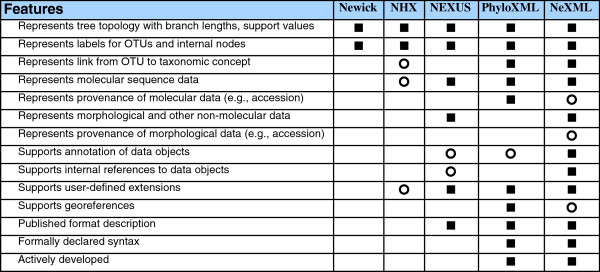
Comparison of file formats commonly used to represent trees. The features of various formats in common use are compared, with a square indicating support for a feature, and an open circle indicating partial or incomplete support. The Newick format represents trees (and no other information) as a series of parenthetical statements representing internal nodes, taxon names, and optionally branch lengths (as described in http://evolution.genetics.washington.edu/phylip/newicktree.html). NEXUS [13] utilizes Newick strings, but also may store character information, processing commands (e.g., to exclude certain OTUs or characters), and notes. There is no formal way to propose extensions to NEXUS, but it has been widely adopted. PhyloXML [20] can store trees and molecular data, as well as accession numbers, geographic information, and other data. NeXML [21] is a different data format intended as an XML-based replacement for NEXUS. Both PhyloXML and NeXML have a formal syntax in an XSD schema. For further information, see [21].